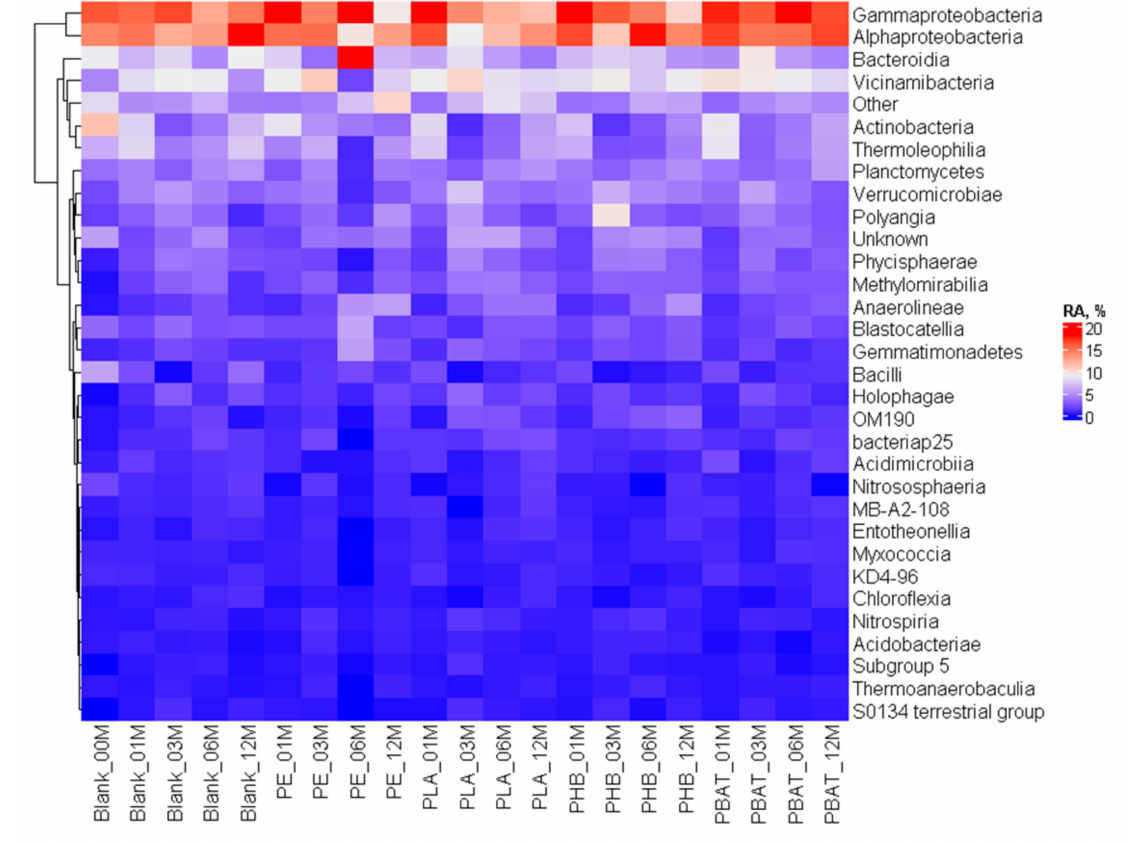
Figure 9. Heatmap of the bacterial community composition and time evolution at the class